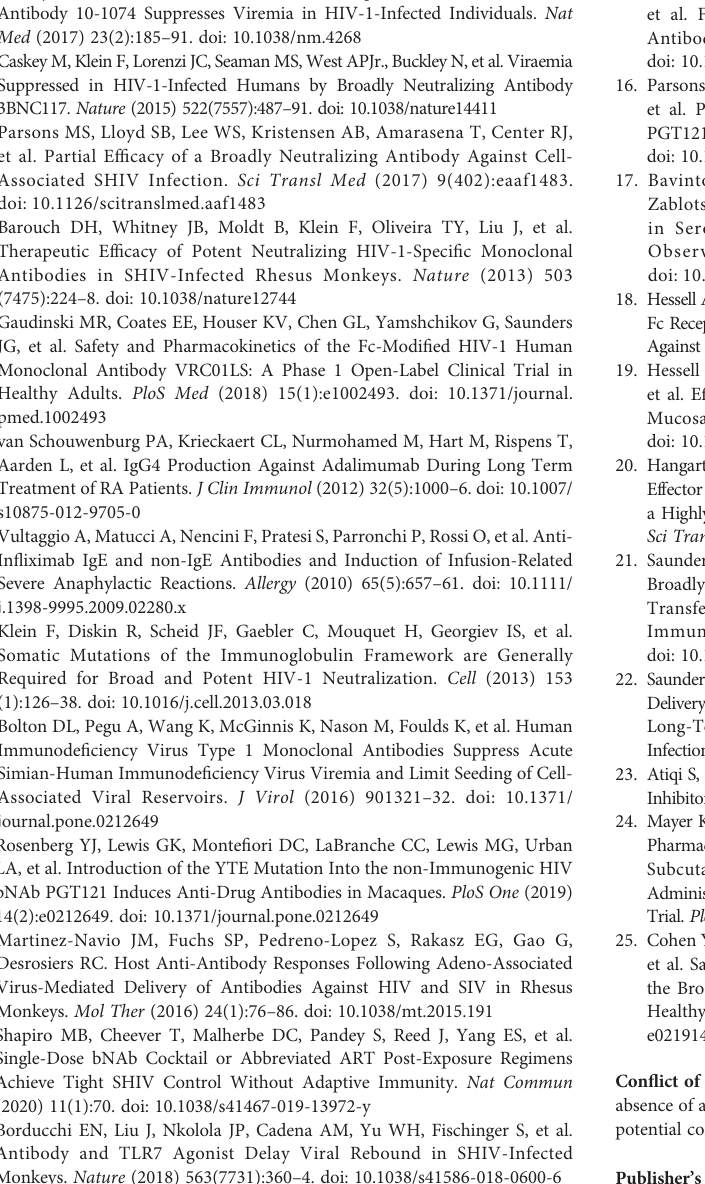
Supplementary Figure 1 | The development of anti-PGT121 ADA following multiple exposures to human antibodies in individual macaques. Macaque anti- PGT121 ADA are shown in the blue line (left y-axis) while SHIV viral loads are shown in the red line (right y-axis). Black arrows indicate antibody administration